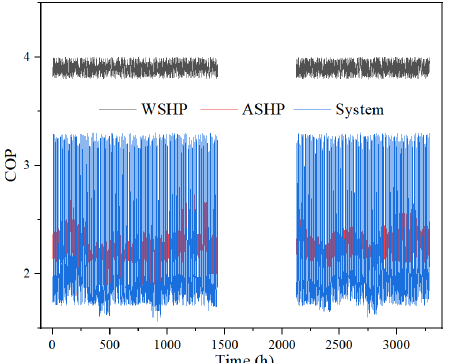
Figure 7. The hourly COP s during heating period.